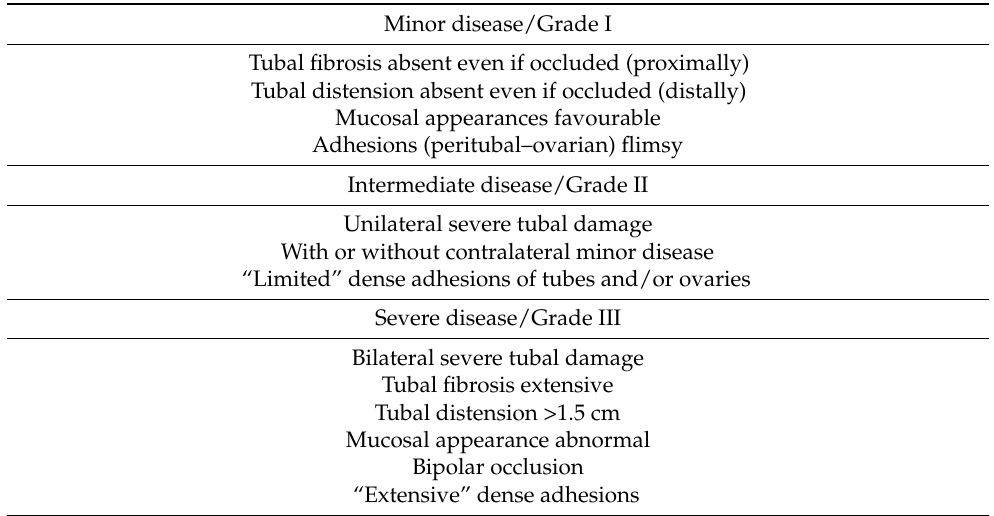
Table 2. Hull and Rutherford classification of tubal/pelvic disease [25]. Minor disease/Grade I Tubal fibrosis absent even if occluded (proximally) Tubal distension absent even if occluded